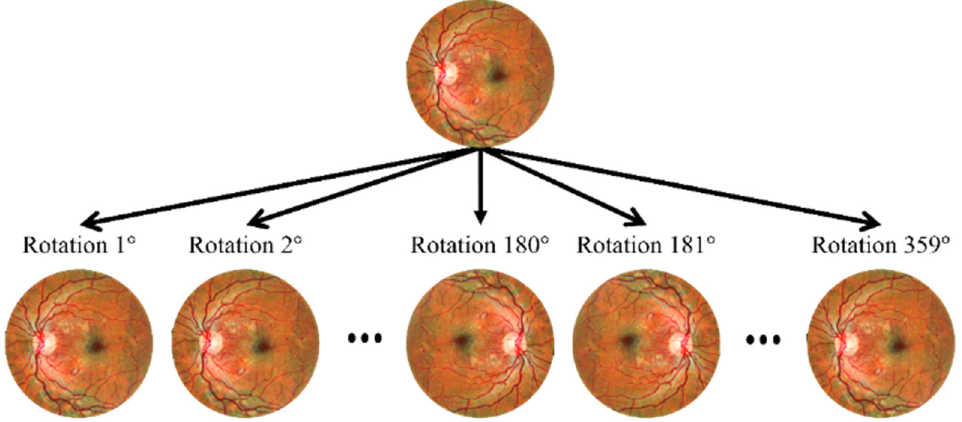
Figure 9. Image Augmentation with Rotation 1°.